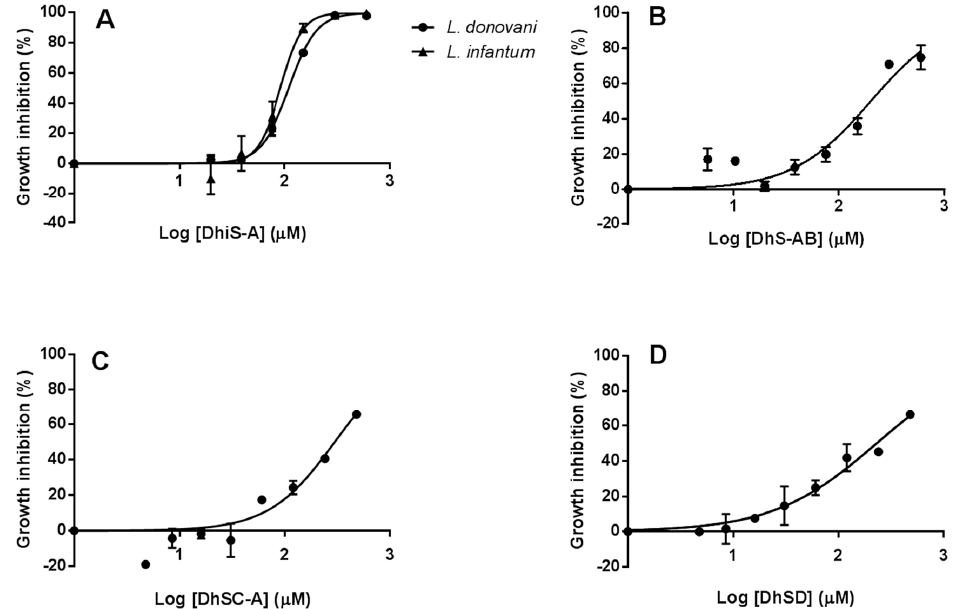
Figure 2. A. Inhibitory effect (%) of different concentrations of dehydroisosilybin A (DhiS-A) on the multiplication of Li (UCM9) and Ld promastigotes ( A ). Inhibition (%) of the proliferation of Li promastigotes by dehyrosilybin AB (DhS-AB) ( B ), dehydrosilychristin A (DhSC-A) ( C ) and dehydrosilydianin (DhSD) ( D ). Concentrations are given as log x+1 .